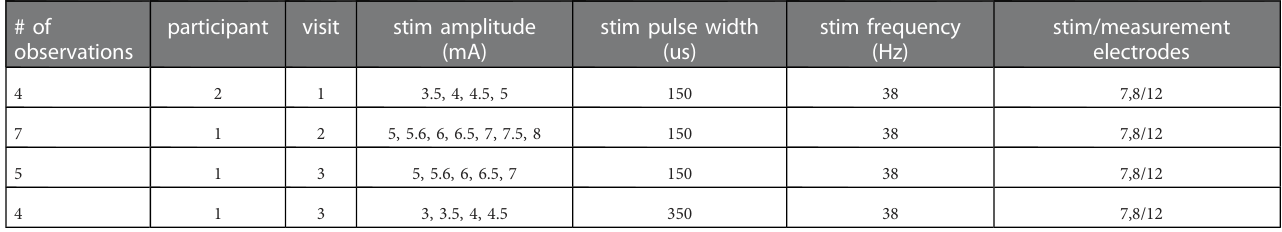
TABLE 3 The 20 observations across participants and stimulation parameters # of observations